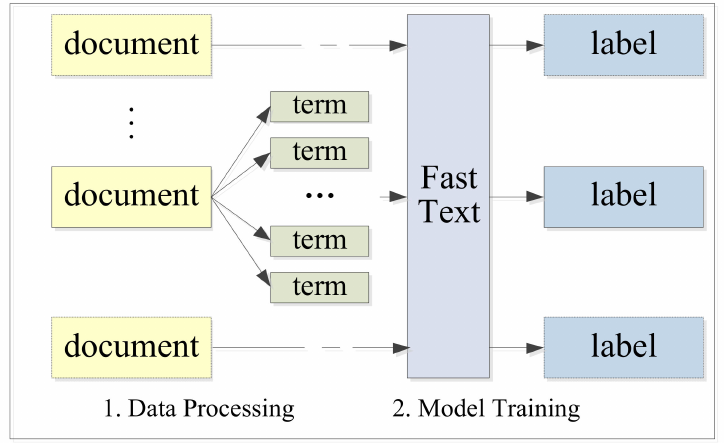
Figure 2. The process for street name text